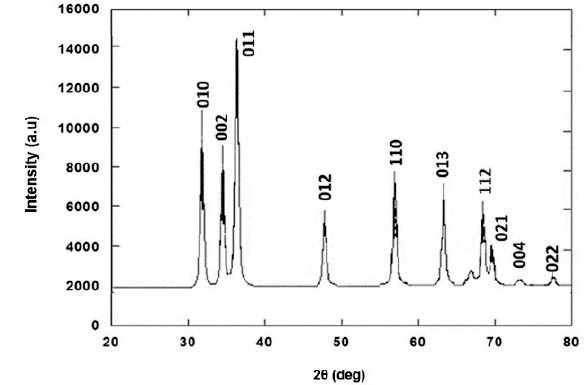
Figure 1. XRD pattern of synthesized ZnO nanoparticles.